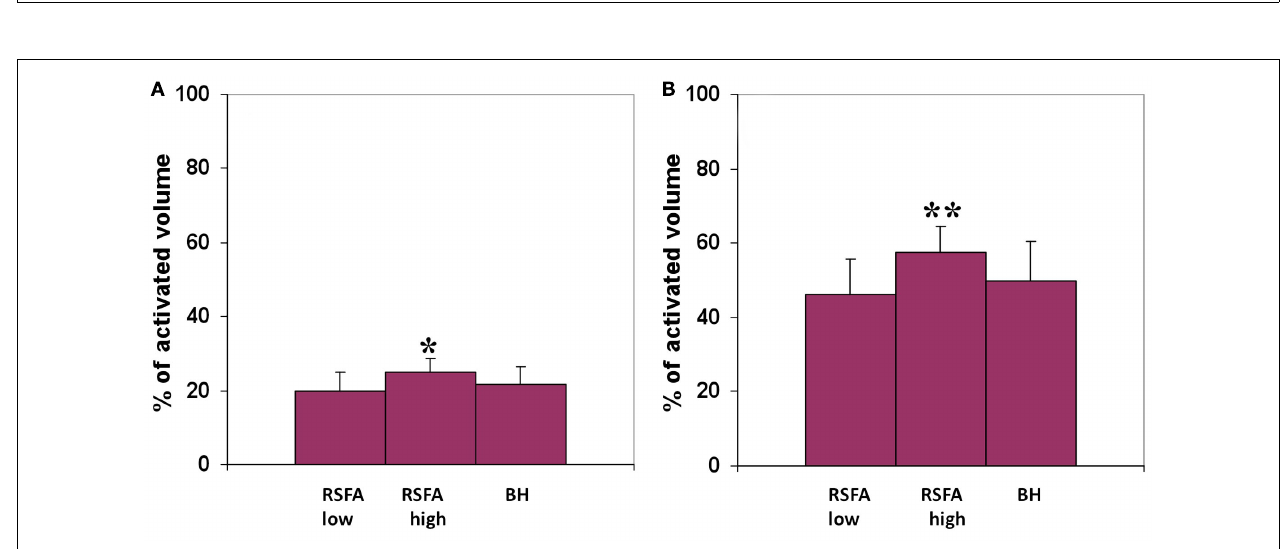
FIGURE 6 | Subject-wise relationship of the low and high frequency components of RSFA between themselves and BH. (A) High frequency RSFA vs low frequency RSFA ( r = 0.67; P < 0.02), (B) BH vs high frequency RSFA ( r = 0.51; P < 0.05), and (C) BH vs low frequency RSFA ( r = 0.70;